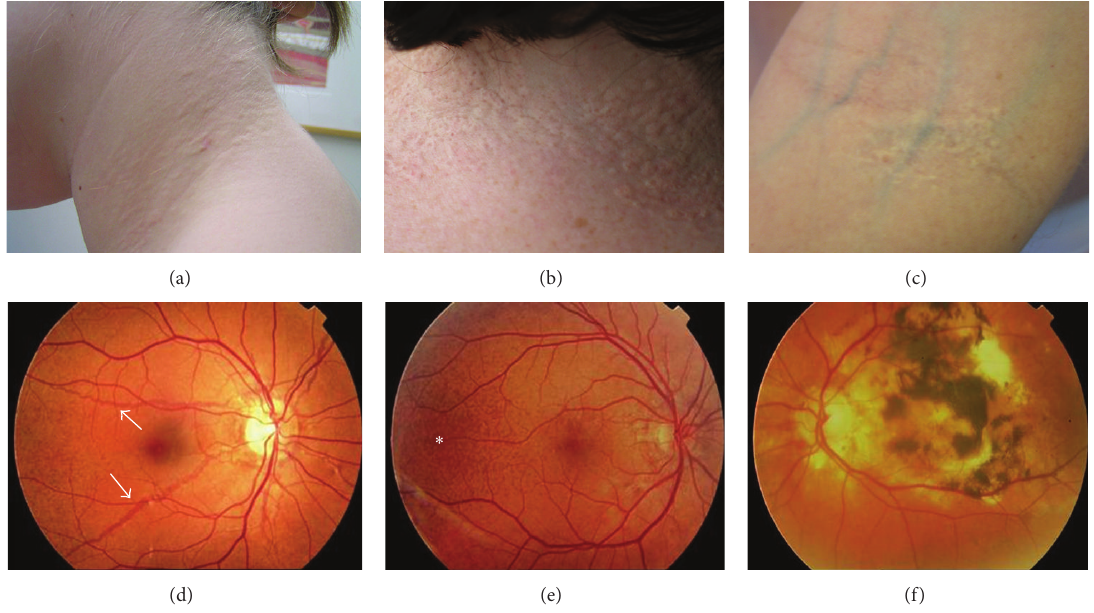
F 1: Cutaneous and ophthalmological features of PXE. �kin lesions include yellowish papular lesions in neck and �exural areas (a–c), oen coalescing into larger plaques (b). In fundo, angioid streaks (d, arrowed) can be observed, as well as a mottled aspect of the fundus called peau d’orange (e, asterisk). Following neovascularisation, subretinal haemorrhage and vision loss can occur